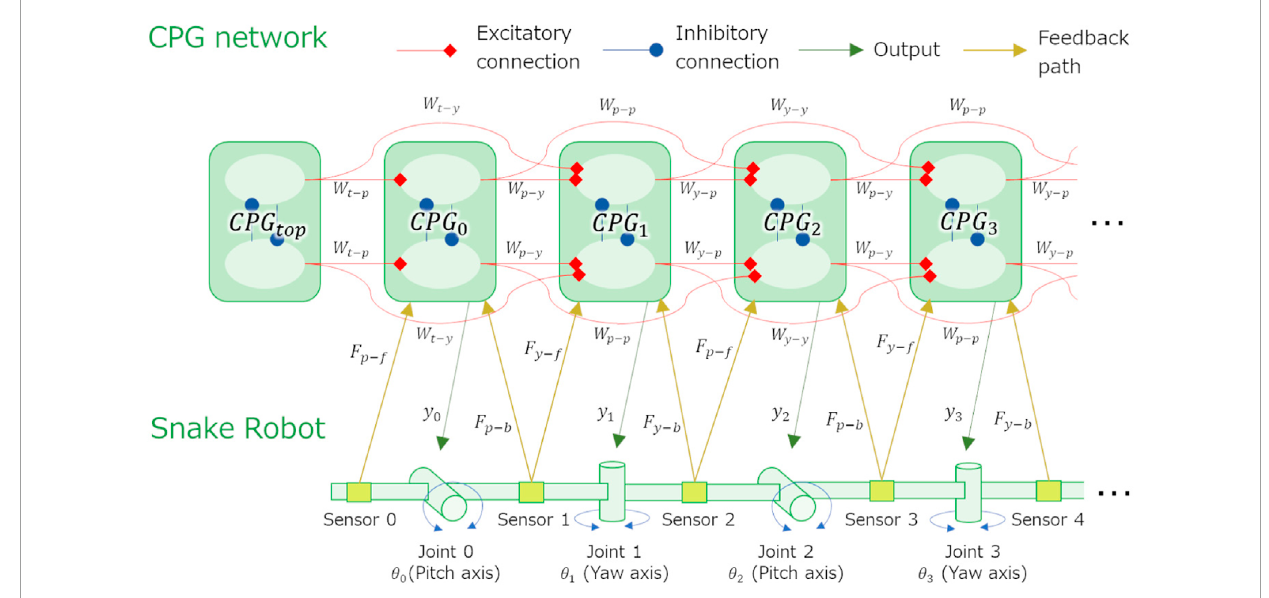
FIGURE 6 The central pattern generator (CPG) network in this study.